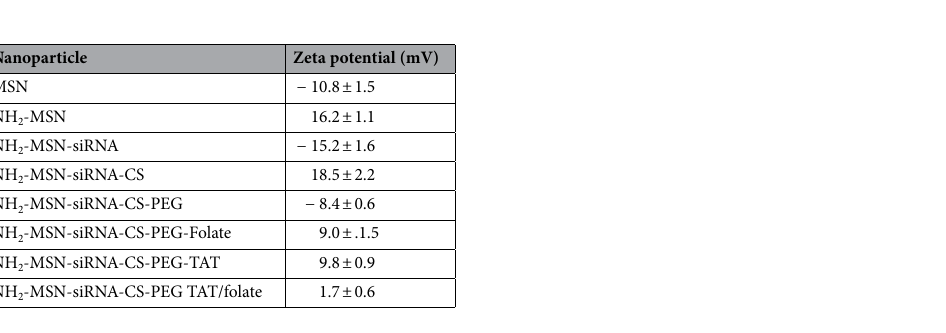
Table 1. Zeta-potential of nanoparticles. CS Chitosan, PEG polyethylene glycol, TAT trans-activator of transcription.